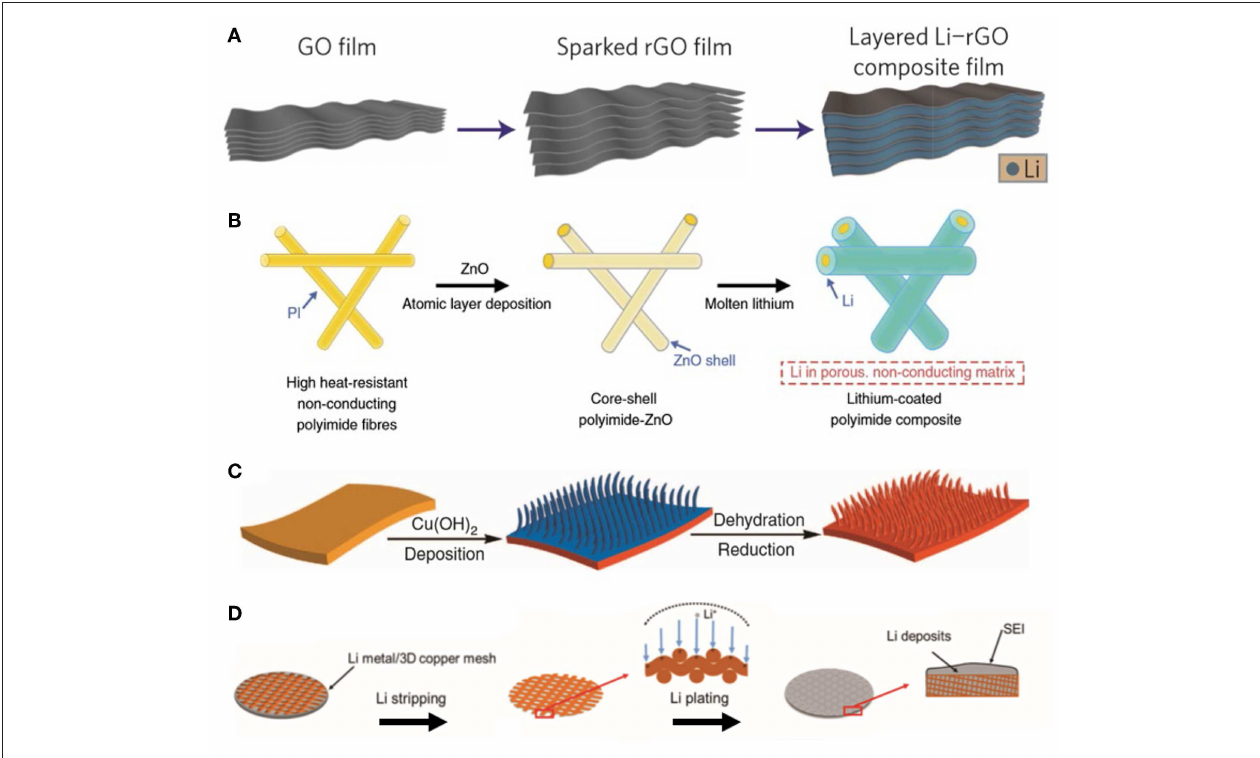
FIGURE 2 | (A) Schematic of the preparation process of a layered Li-rGO composite film (Lin et al., 2016b). Copyright 2016 Springer Nature. (B) Composite Li anode based on electrospun polyimide PI coated with a layer of lithiophilic ZnO (Liu Z. C. et al., 2019). (C) Preparation of a 3D porous copper (Yang et al., 2015). (D) The surface of Li anode modified with copper mesh exhibits uniform Li deposition (Li Q. et al., 2017). Copyright 2017 John Wiley and Sons.